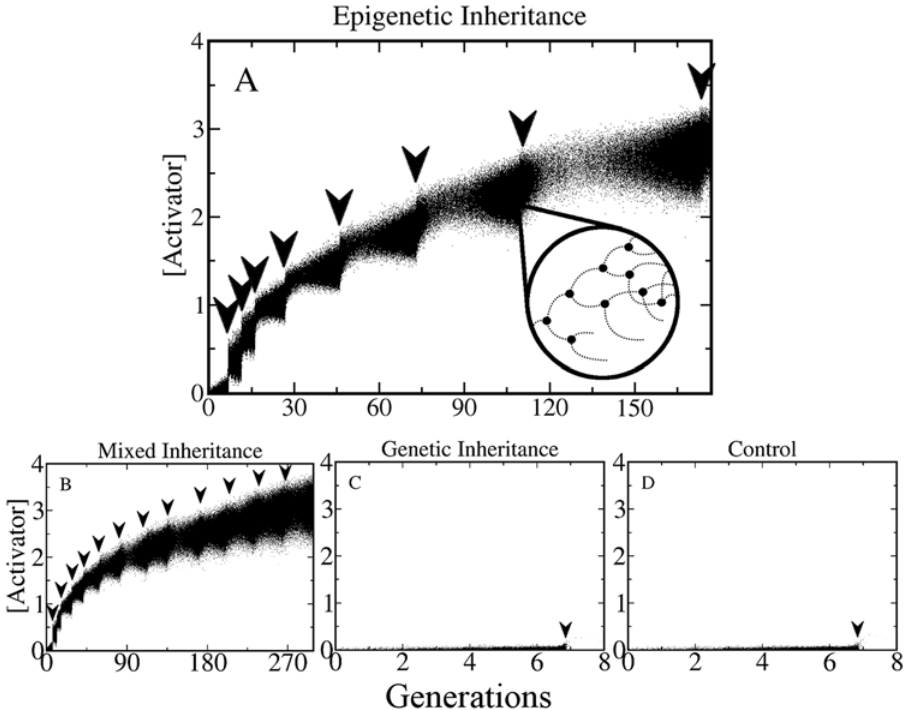
Fig 2. Emergence of the high resistance phenotype. This figure shows tracking plots of populations growing in successively increasing concentrations of antibiotic. For each cell the concentration of Activator is plotted at constant time intervals (dots). The arrows indicate the times at which antibiotic shocks were applied, which happened every time the population reached a maximum size of N = 5000. The four panels correspond to the four different inheritance scenarios mentioned in the main text. (A) Only epigenetic inheritance is implemented. (B) Mixed Inheritance. (C) Only genetic inheritance and (D) control (no inheritance). The inset in (A) shows a zoomed in representation of the tracking plot, where one cell lineage is followed as it goes through several cell divisions and deaths. Since dead cells are removed immediately from the population, their expression is no longer visible and their curves terminate abruptly (causing a step-like structure). Note that high levels of resistance can be achieved only when there is epigenetic inheritance (A and B). Otherwise, the entire population dies after the first shock (C and D). The unit of time corresponds to one cell cycle for β 0 = 1 and with no antibiotic (see S6